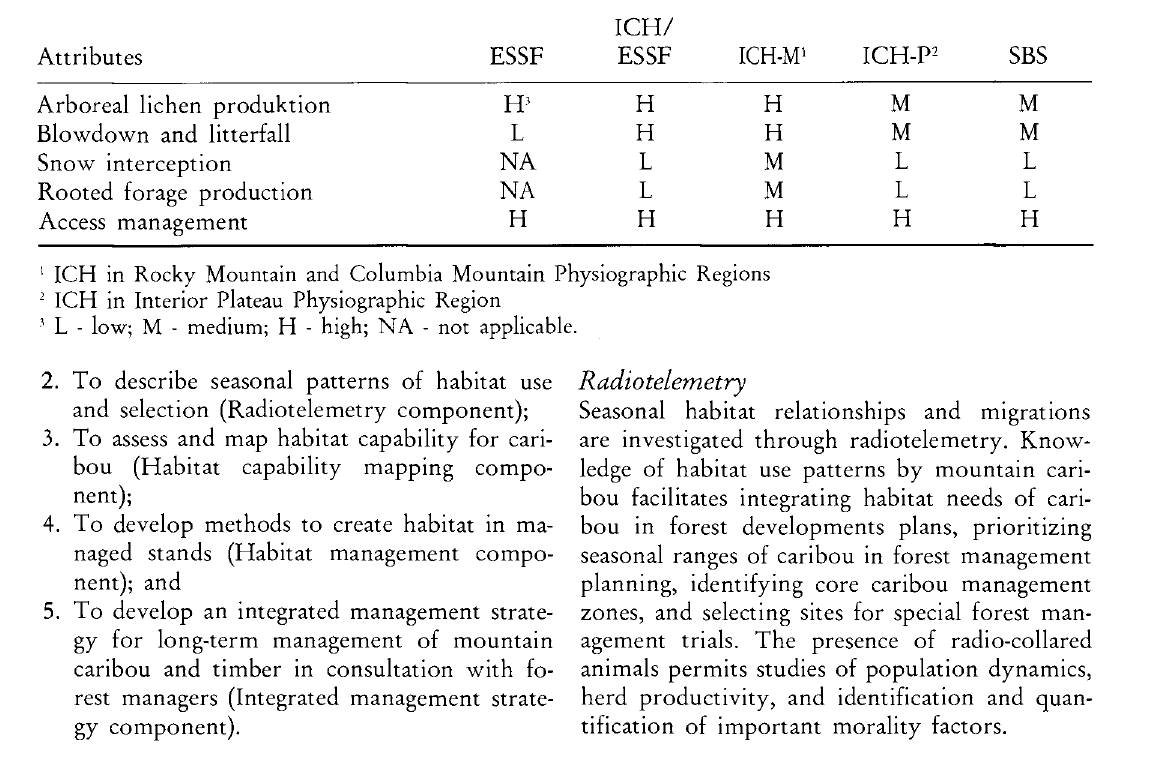
Table 1. Estimated importance of key attributes of caribou winter range in various biogeoclimatic zones.